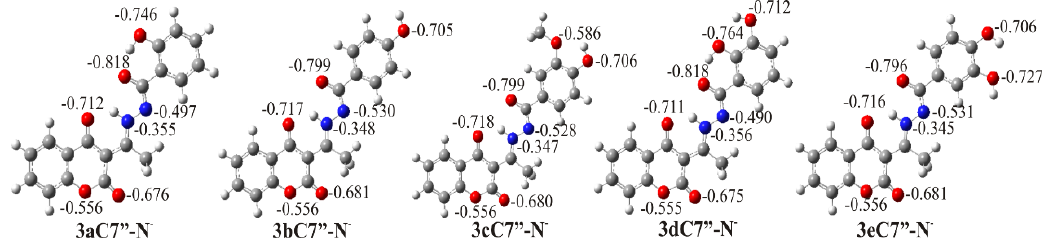
Figure 3. The NBO charge delocalization for anions obtained by proton abstraction from -NH group in position C7”-N for investigated compounds.